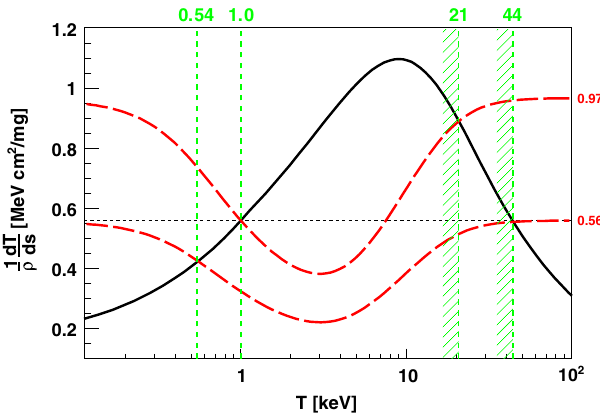
FIG. 4. Frictional-cooling energy region of the stopping power of helium for (cid:1) þ (solid curve). The horizontal dashed line shows the naive accelerating power neglecting charge-exchange pro- cesses of an electric field at 0 : 56 MV cm 2 = mg , resulting in T ¼ 1 keV . The two dashed curves show accelerating powers eq with charge-exchange processes accounted for: the lower curve FIG. 5. Ratio of electric field strength required to achieve the ¼ 0 : 54 keV ; the upper is for 0 : 56 MV cm 2 = mg , resulting in T desired equilibrium energy accounting for effective charge to the eq ¼ 1 keV . curve is for 0 : 97 MV cm 2 = mg , resulting again in T field strength required without accounting for effective eq